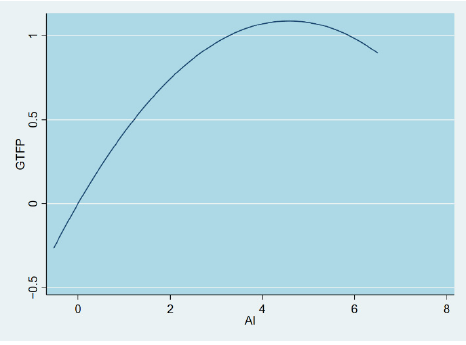
Figure 2. Graph of GTFP vs. AI (after adding moderation effect).